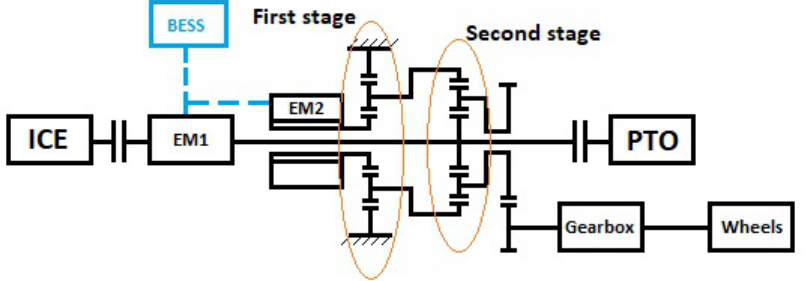
Figure 4. Schematic representation of HeCVT tractor architecture.